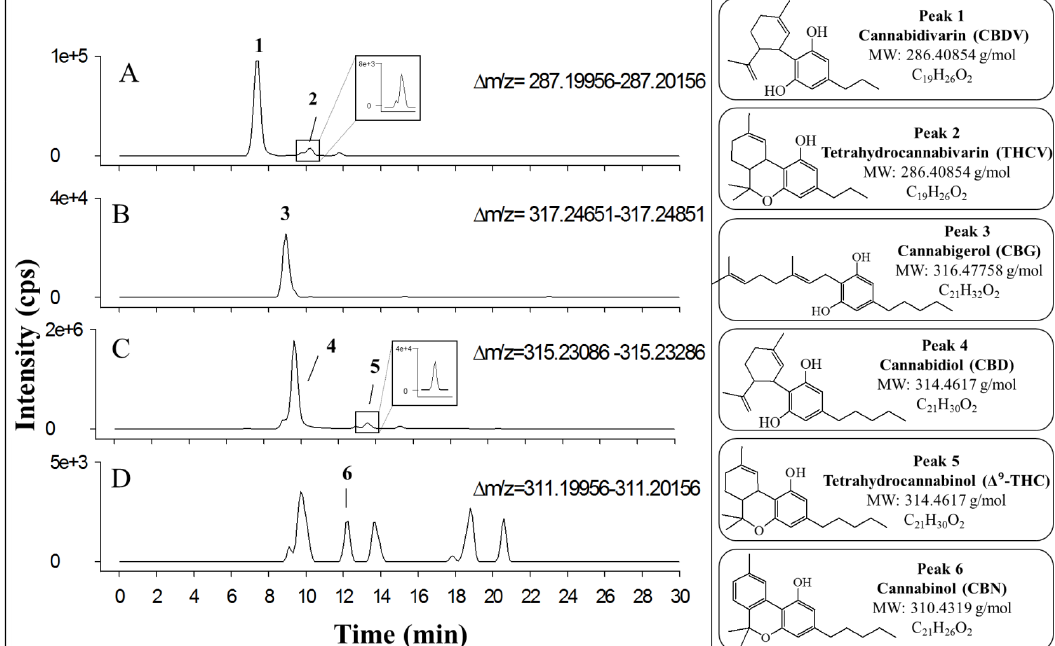
Figure 1. Extracted ion chromatograms using LC/ESI-FTICRMS acquired in positive ion mode of a C. sativa extract ( Eletta Campana ). The monitored ions are displayed in each trace (plots A – D ) and correspond to the protonated molecules, [M+H] + , using a restricted window of 0.0010 m / z unit, centered around each selected ion. Peak numbers correspond to ( 1 ) CBDV, ( 2 ) THCV, ( 3 ) CBG, ( 4 ) CBD, ( 5 ) THC and ( 6 ) CBN. For each cannabinoid, molecular structure, weight, and formula of corresponding neutral forms are reported. Table 1. Cannabinoids occurring in a sample of C. sativa extract ( Eletta Campana ), identified as intact protonated molecules, [M+H] + , using high-resolution LC-ESI (+)-FTICR MS and IRMPD product ions obtained from the protonated ions of the identified compounds.